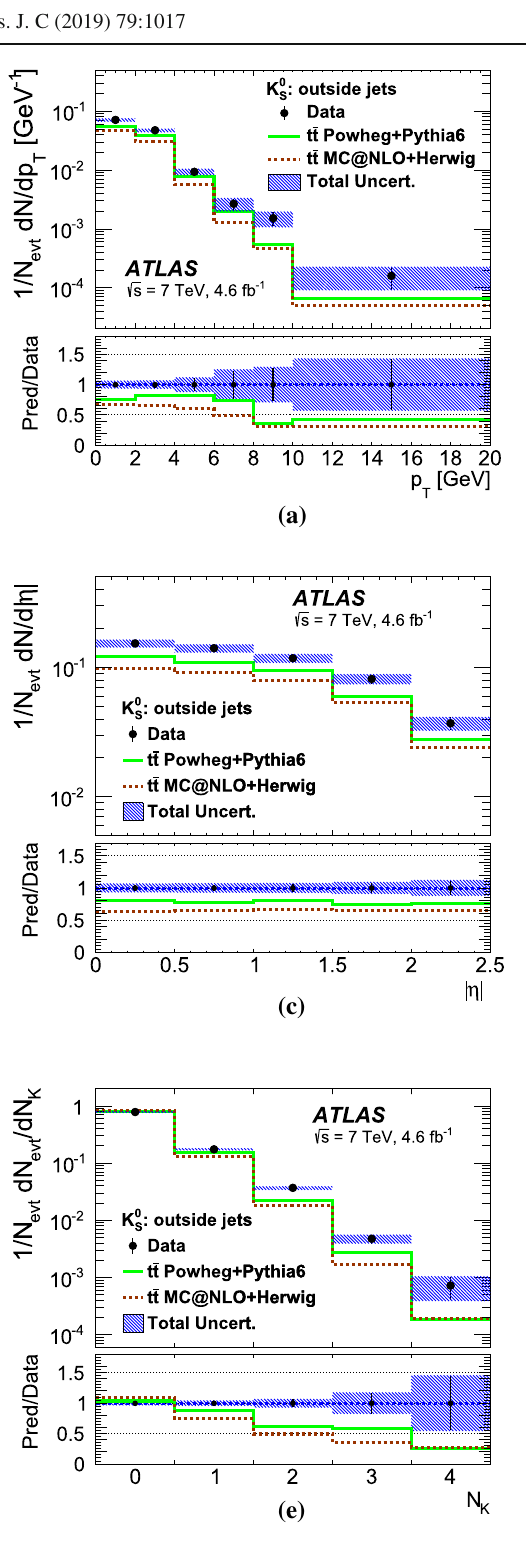
Fig. 5 Kinematiccharacteristicsfor K 0 productionnotassociatedwith representedby the shaded area.Statisticaluncertaintiesfor MC samples S jets,fordataanddetector-levelMCeventssimulatedwiththe Powheg + are negligible in comparison with Pythia6 and MC@NLO + Herwig generators. Total uncertainties are